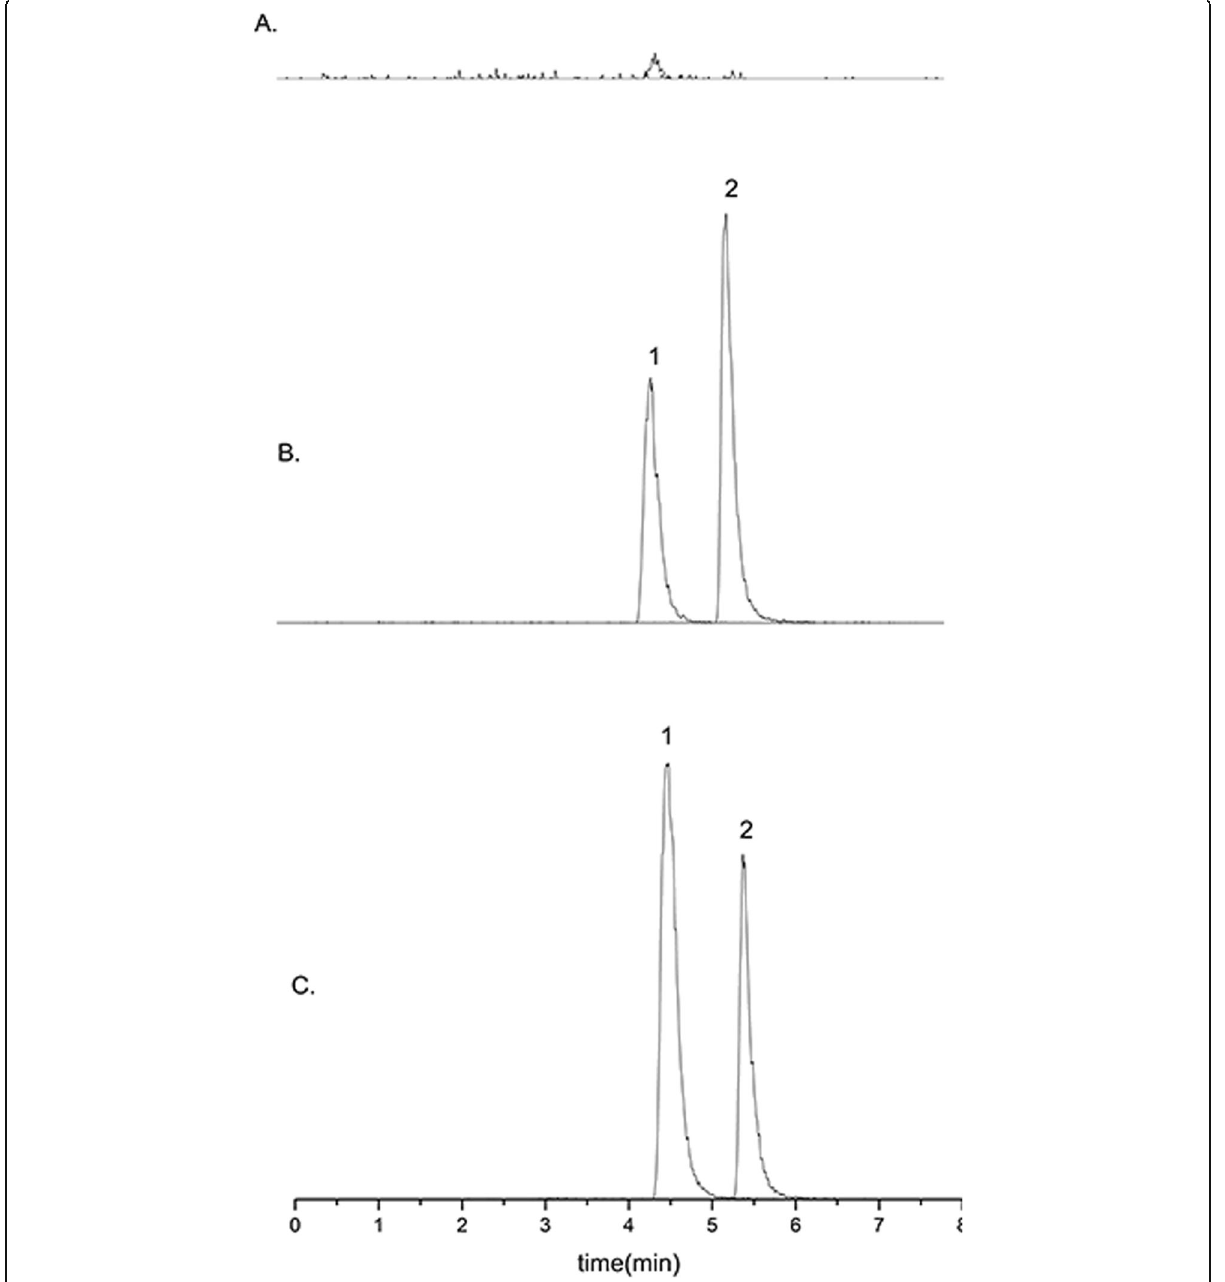
Fig. 2 HPLC of blank plasma ( a ), daidzein + apigenin (internal standards) + blank plasma ( b ), and plasma sample ( c ). 1, daidzein; 2, apigenin